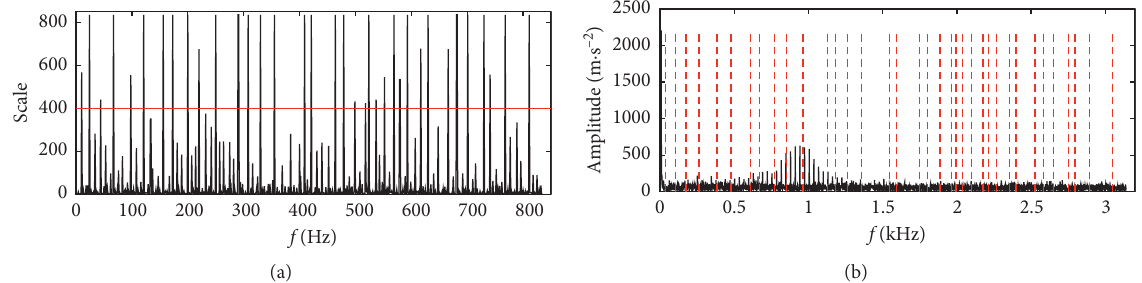
Figure 3: Obtain the boundary point and divide the spectrum. (a) The scale-space method obtains initial boundary points. (b) Divide the